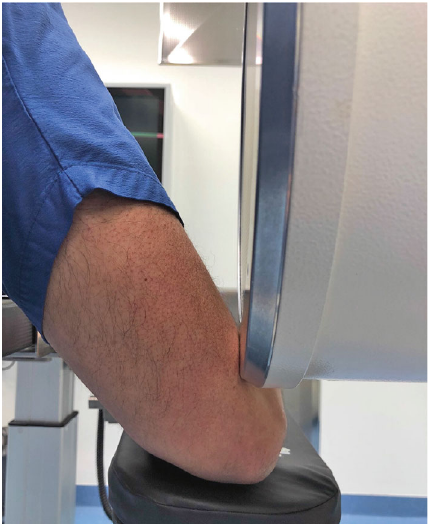
Figure 3: Radial nerve sustained a compression by the C-arm fl uoroscopy — close